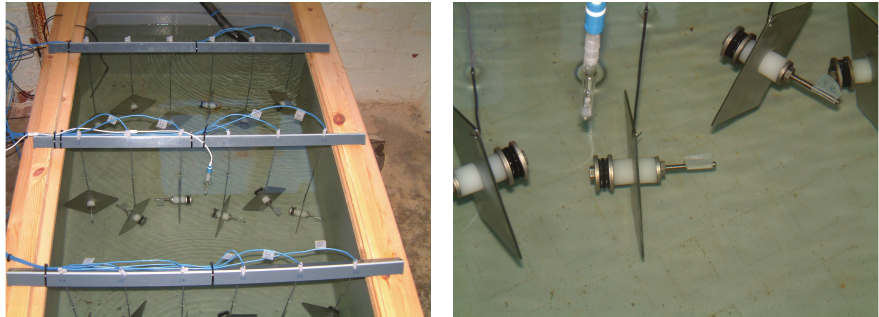
Figure 4: Test setup for crevice corrosion testing in seawater corrosivity comparison test series.